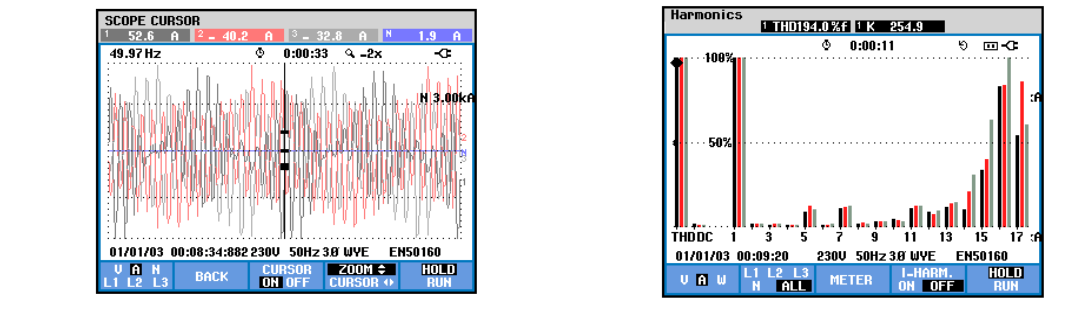
Figure 24. Waveforms of grid current and its harmonic spectra with common control strategy shunt APF prototype after parallel capacitance load is connected at the point of common coupling (PCC).